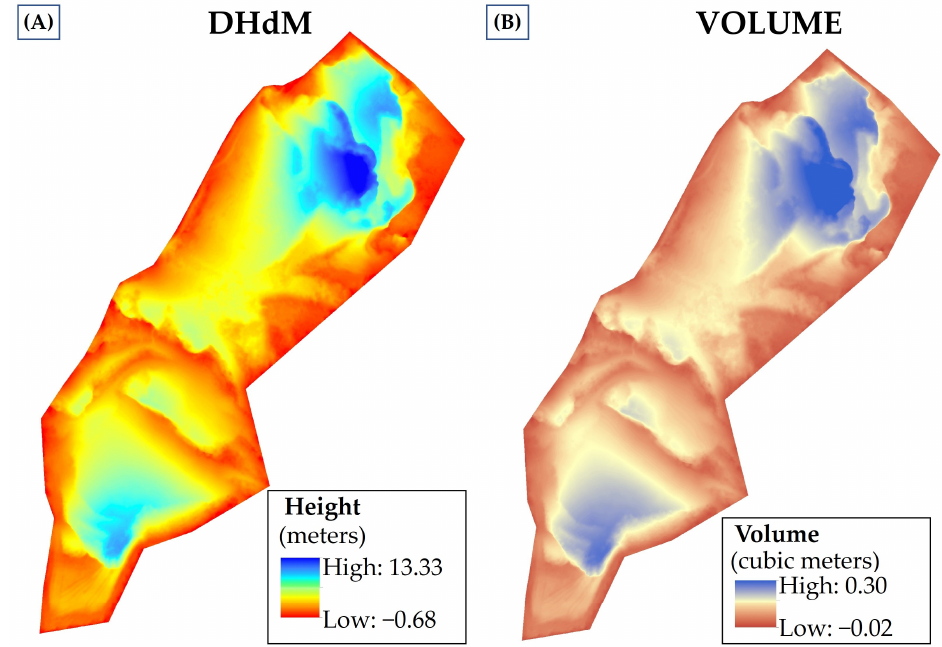
Figure 5. ( A ) Calculation of the height difference (DHdM) value between the restored DEM (DEM(r) and the drone-acquired DEM-DRONE. ( B ) Calculation of the volume needed to obtain the DEM(r), obtained by multiplying the pixel area (in this study case 0.255 m 2 ) and the DHdM pixel